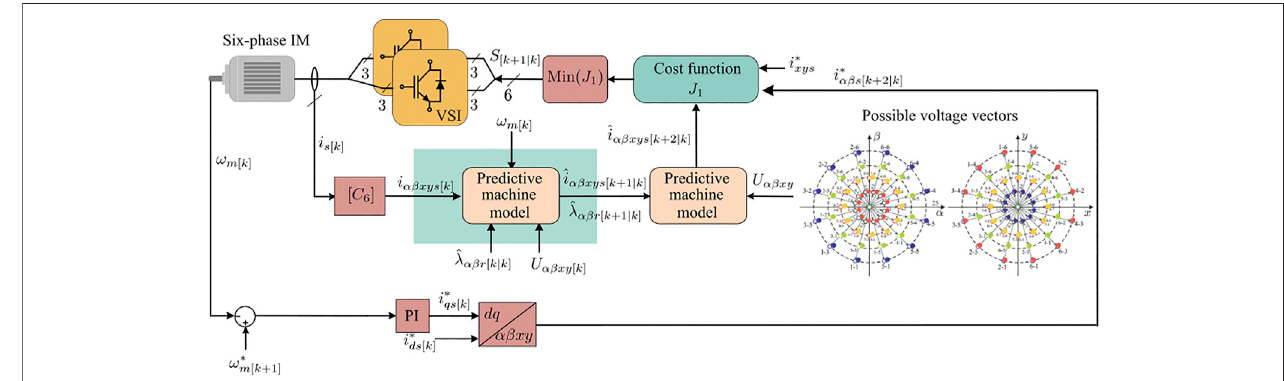
FIGURE 8 | Classic MPC scheme for asymmetrical six-phase